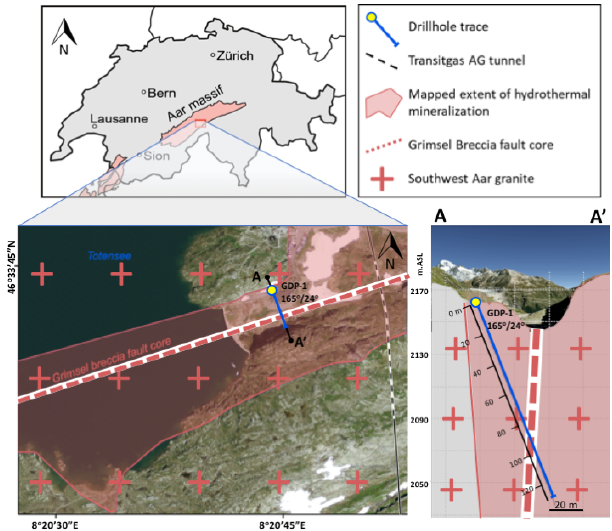
Figure 1. Lower left shows an aerial image (source: Federal Office of Topography, https://www.swisstopo.ch, last access: 10 Febru- ary 2017) of the Grimsel Pass showing the trace of the GDP1 bore- hole, the extent of mineralized outcrops associated with the GBF (Belgrano et al., 2016), and the location of the Transitgas AG tun- nel with the interval of active hydrothermal inflow marked by the white stippled line (modified from Egli et al., 2018). The lower right shows a schematic cross section through the plane of the borehole intersecting the GBF showing the extreme topographic relief in con- junction with the location and orientation of the borehole (modified from Greenwood et al.,